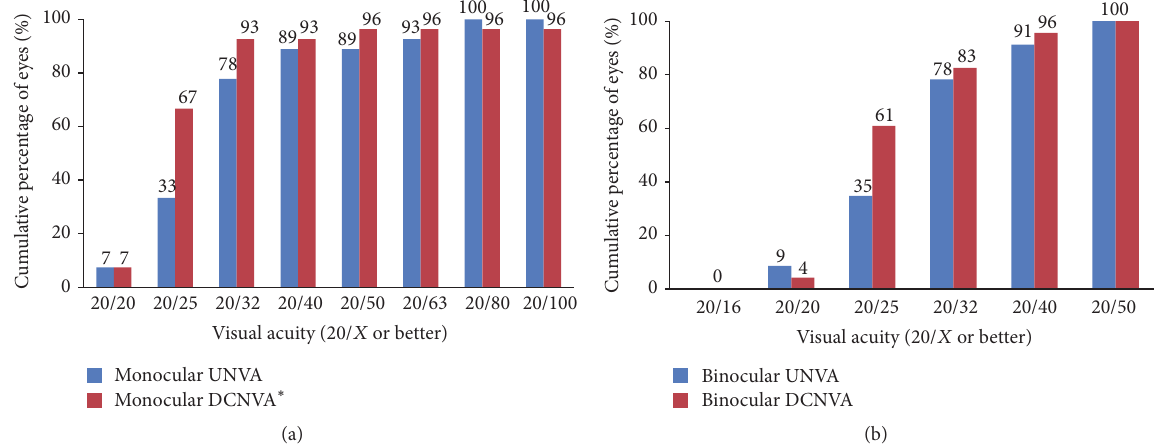
Figure 4: Monocular (operated eyes) and binocular uncorrected near visual acuity (UNVA) and distance-corrected near visual acuity (DCNVA) at 30 cm at the last visit. ∗ One eye (4%) had DCNVA of